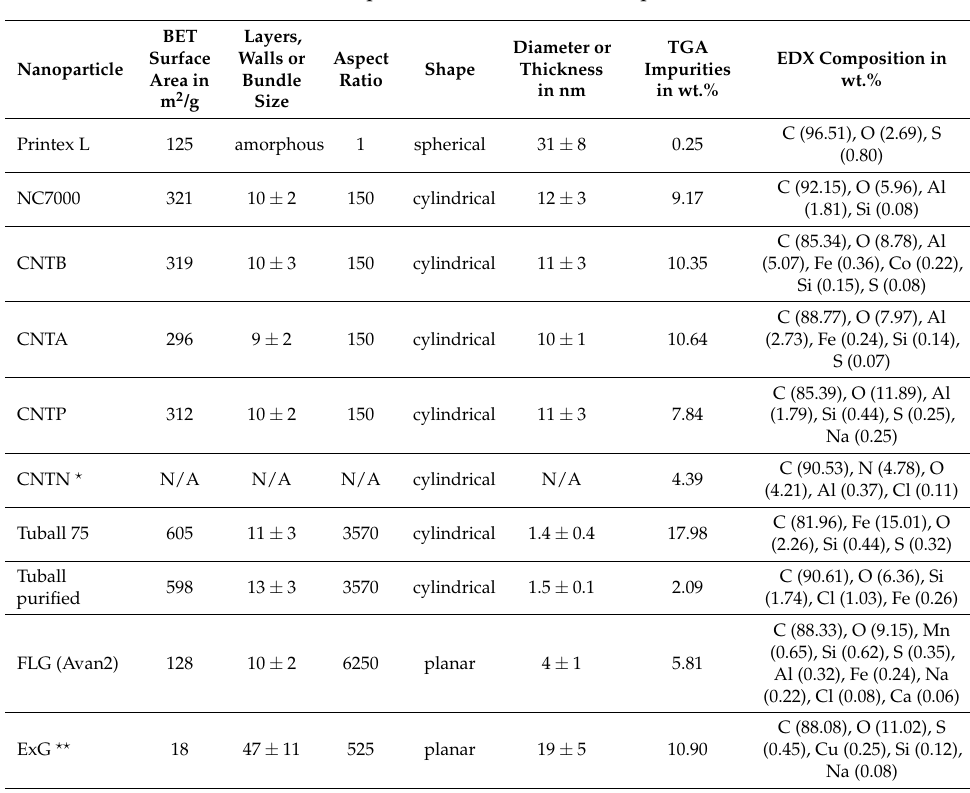
Table 2. Properties of used carbon